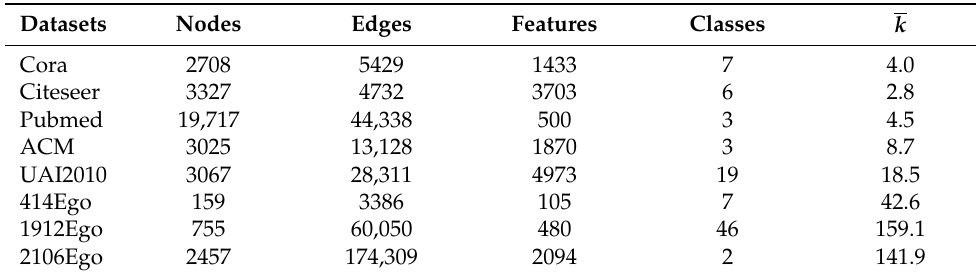
Table 1. Summary of the